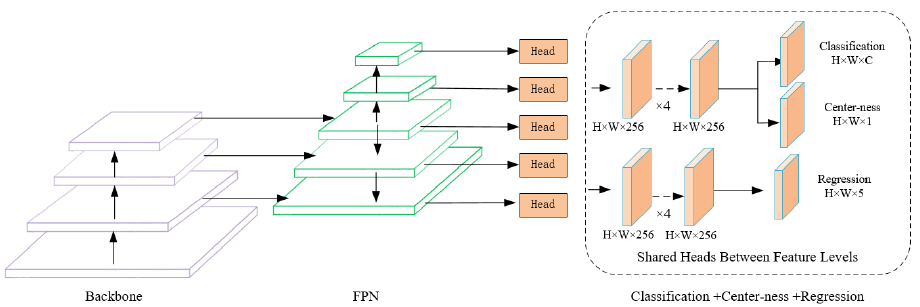
Figure 15. The network architecture of Rotated FCOS.